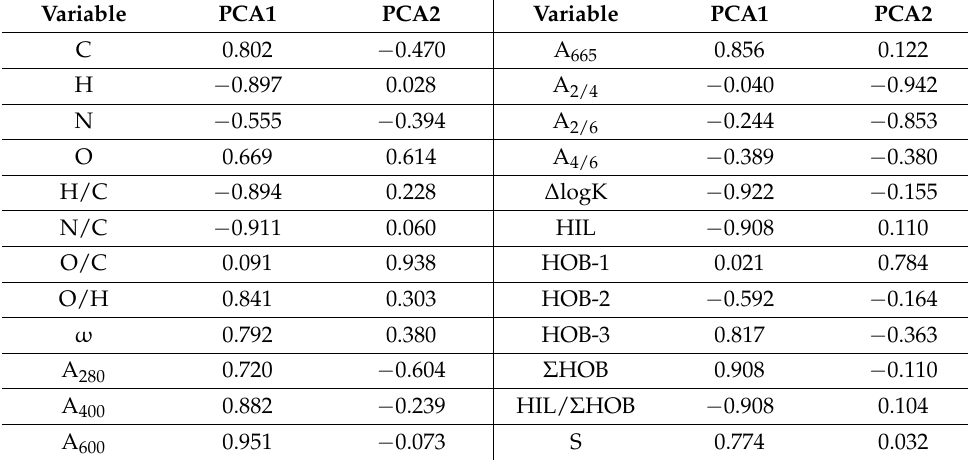
Figure 4. Configuration of variables in the system of the first two axes PCA1 and PCA2 of principal components. Table 10. Loading scores of the variable for PCA.